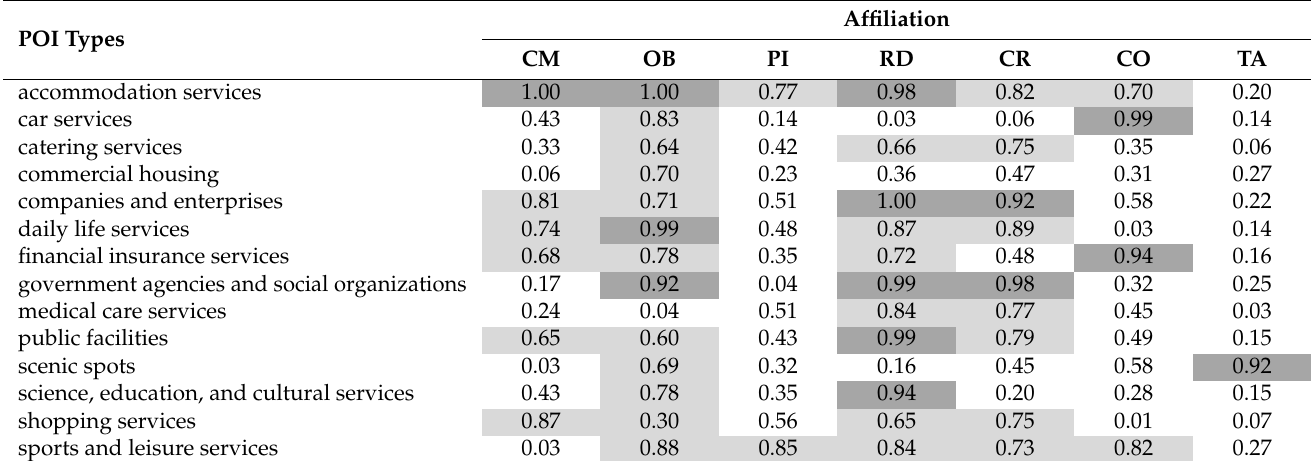
Table 6. The correlations between POIs and parking in different affiliation